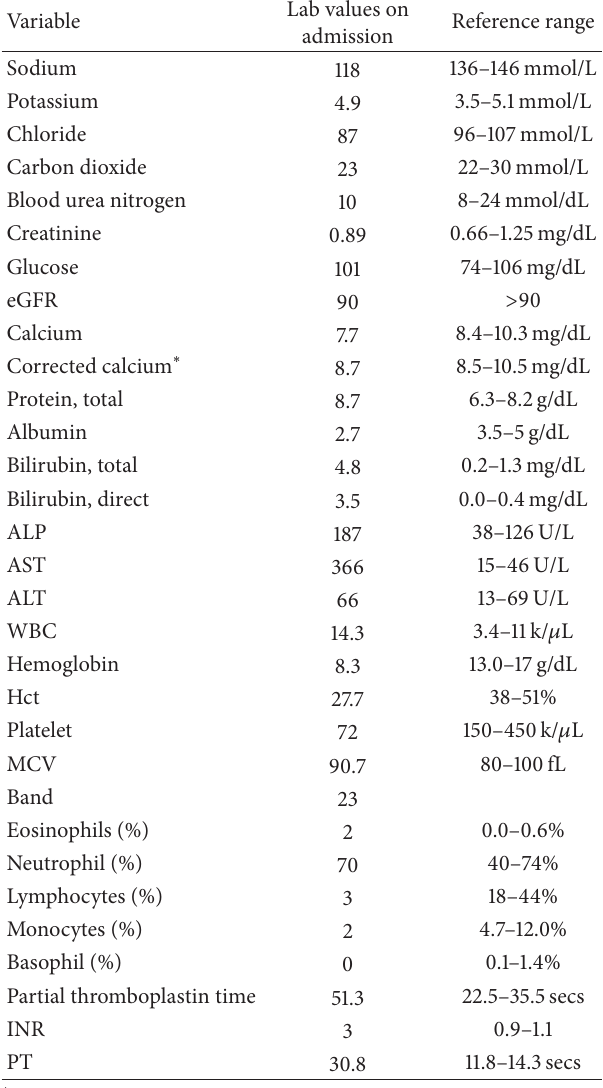
Table 1: Lab values on